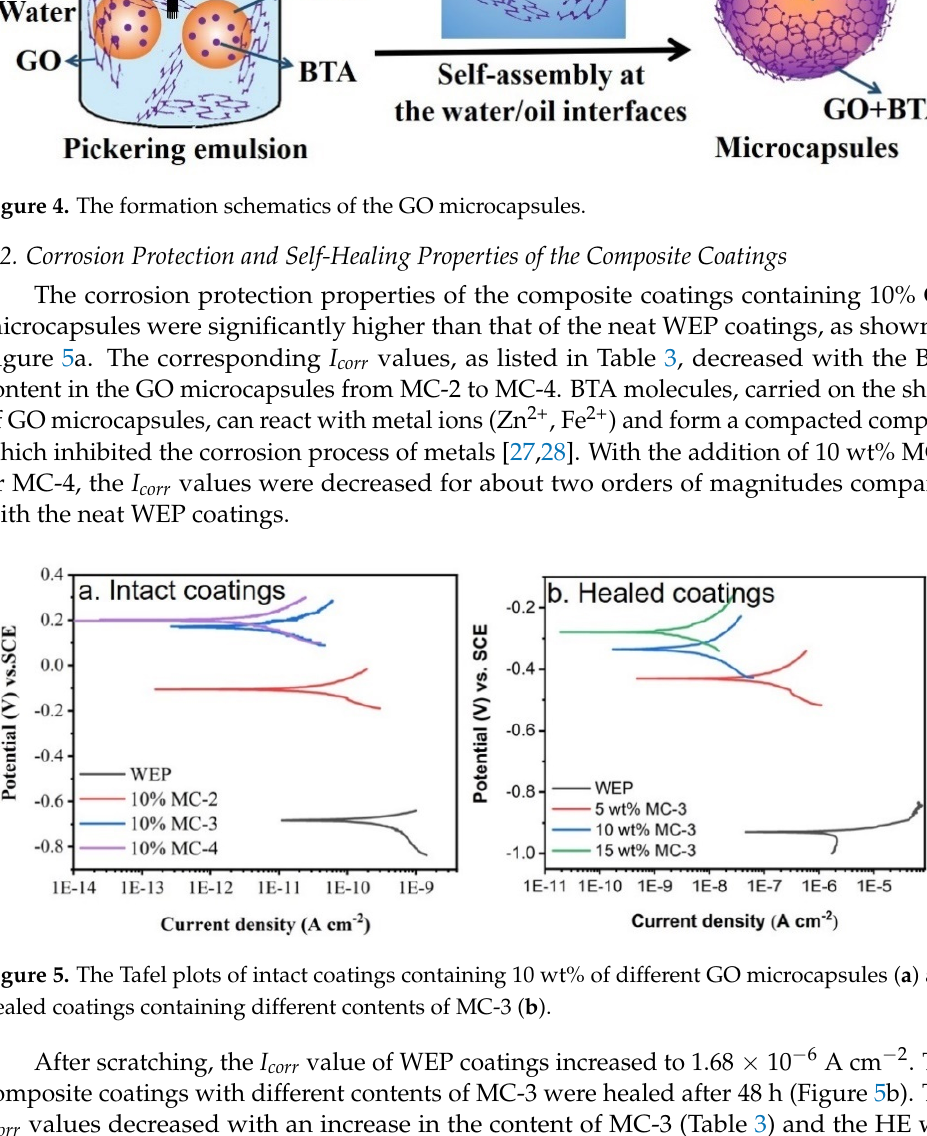
Figure 5. The Tafel plots of intact coatings containing 10 wt% of different GO microcapsules ( a ) and healed coatings containing different contents of MC-3 ( b ).